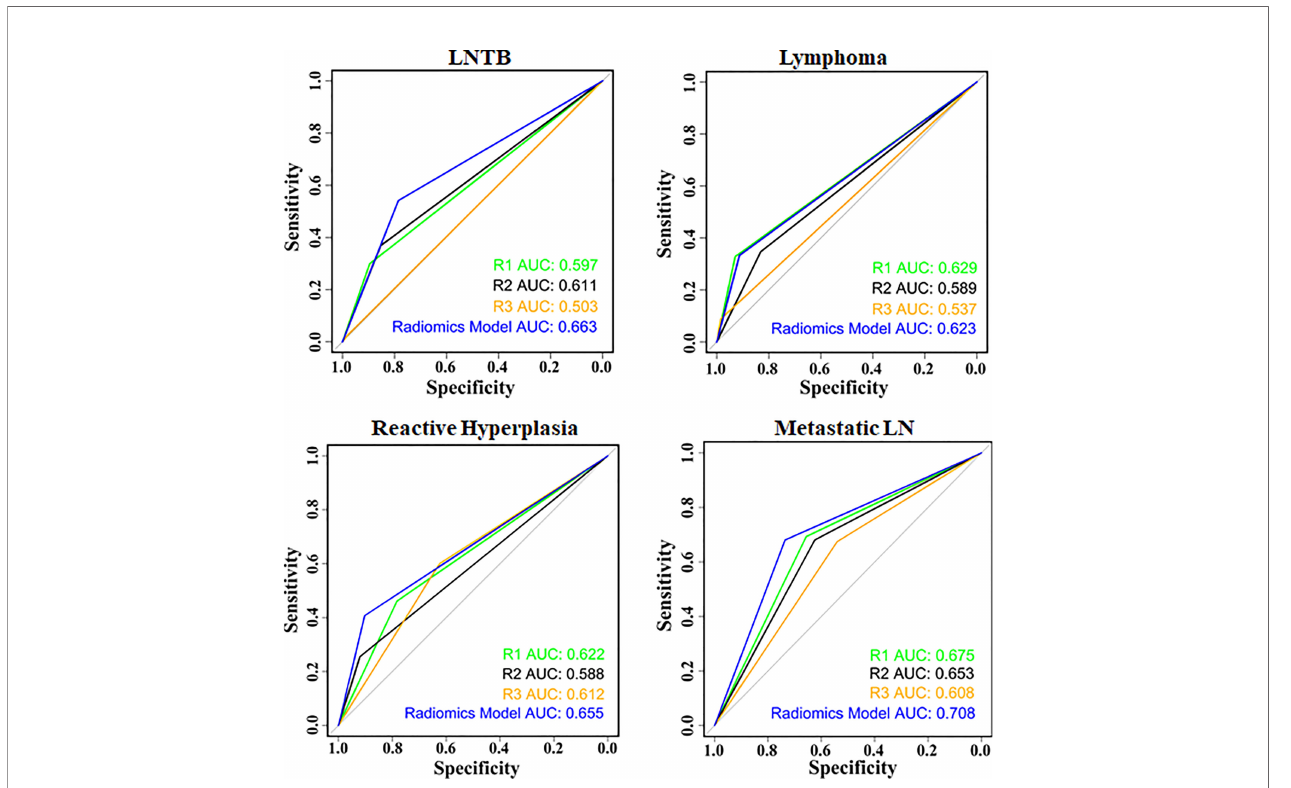
FIGURE 4 | Receiver operating characteristic between the radiomics model and radiologists in the whole